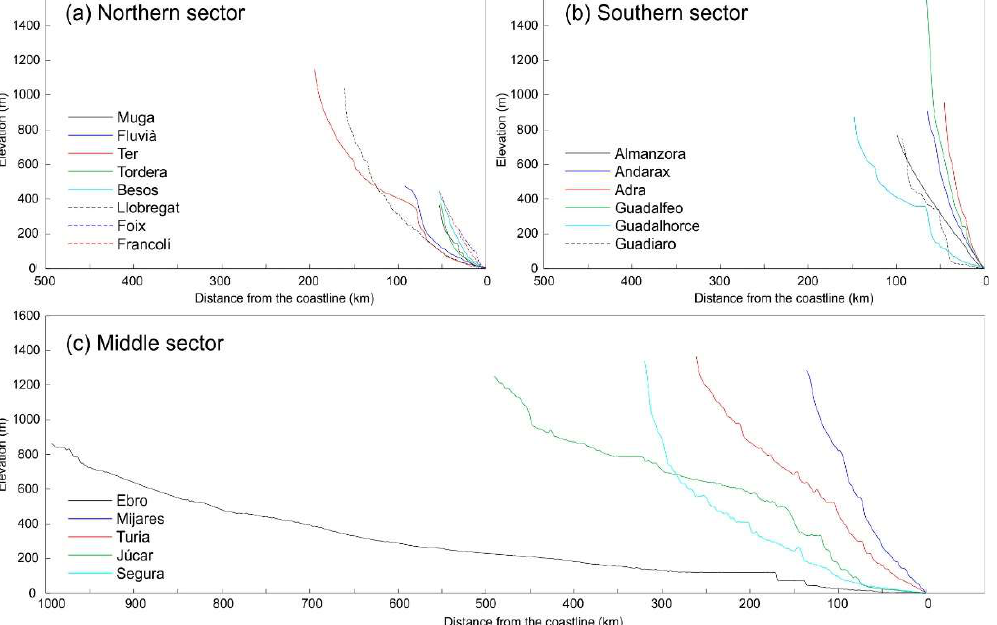
Figure 14. River profiles of each sector of the Iberian Mediterranean shelves. Note the increasing slope of the studied rivers in the southern shelves. See Figure 3 for location.